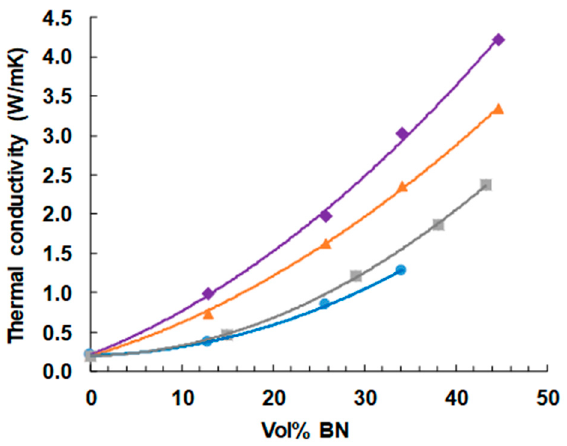
Figure 11. Thermal conductivity of ETLBN and EJBN samples as a function of the BN content: ETLBN2, blue circles; EJBN30, grey squares; ETLBN30, orange triangles; ETLBN180, purple diamonds.